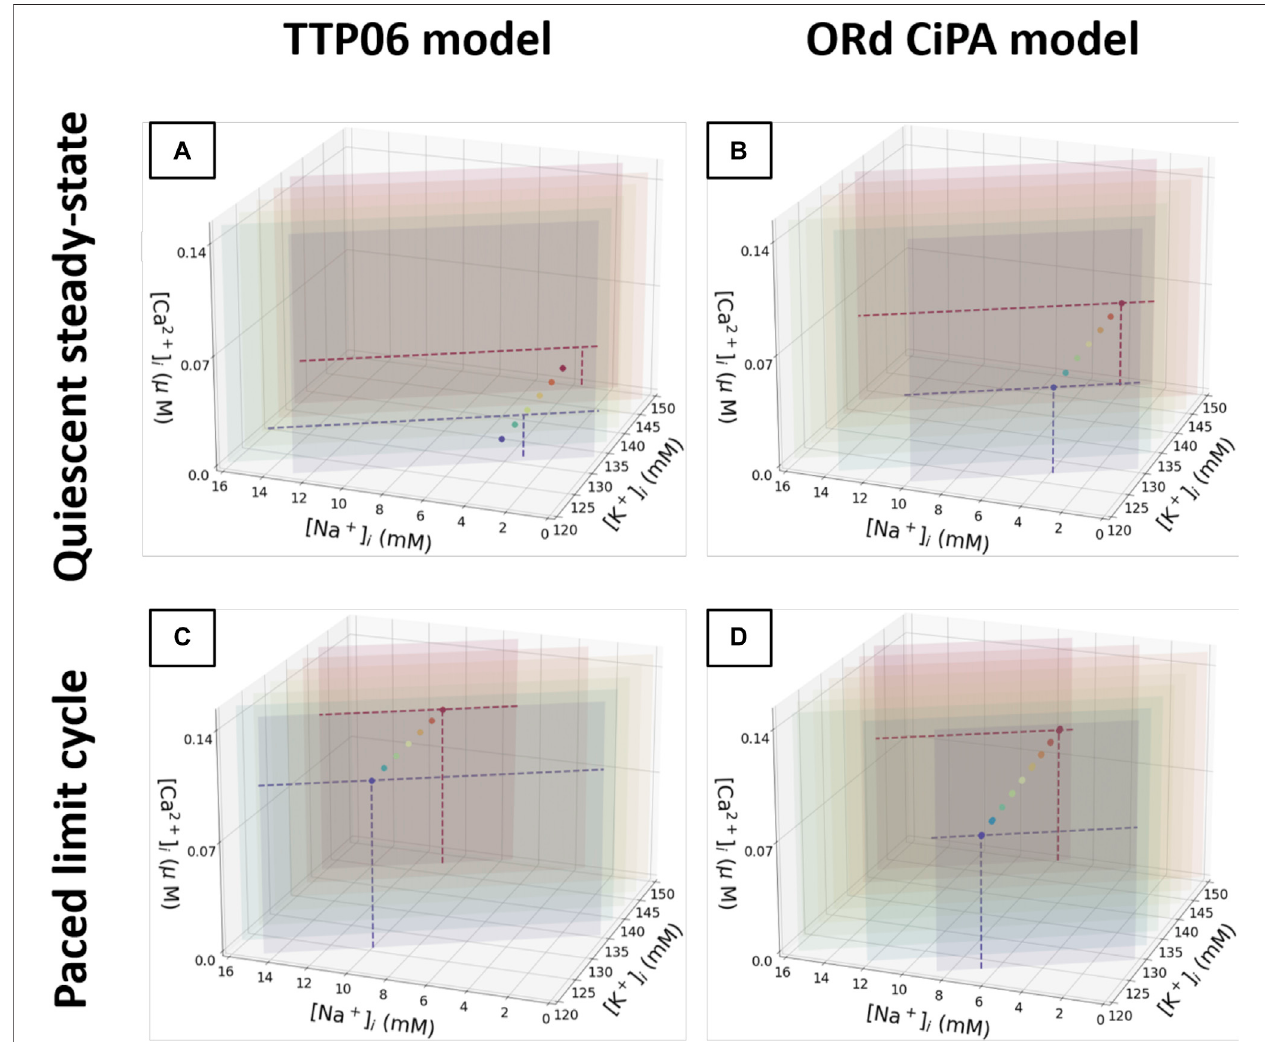
FIGURE 6 | Plot of the quiescent steady state and limit cycle values for [ Na + ] i , [ K + ] i and [ Ca 2 + ] i . (A) : TTP06 model at a quiescent steady state. (B) : ORd-CiPA model at aquiescent steadystate. (C) : TTP06 modelinalimit cycle. (D) : ORd-CiPA model inalimitcycle.Each planehas initialconditionssatisfying Eq. 6 withthesame fi xed Γ 0 value. 100 combinations of initial conditions are sampled from each plane to cover the physiological range of concentrations. These initial conditions are used in simulations to reach the (top row) quiescent steady state and the (bottom row) paced limit cycle. The steady state and limit cycle concentrations are plotted as points (with dashed projections along the associated Γ 0 plane), with the colour matching the plane from which the initial conditions were sampled. For clarity, the planes for which the quiescent steady state is out of the range reported in Section 3.2 , are not shown.